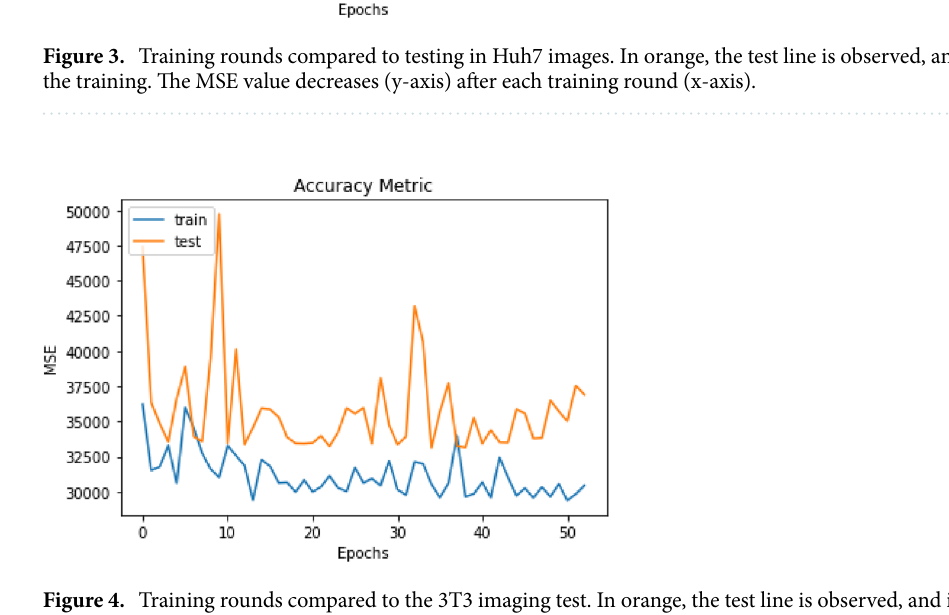
Figure 4. Training rounds compared to the 3T3 imaging test. In orange, the test line is observed, and in blue, the training. From each training round (x-axis), the MSE value dis not synchronized between test and training and remains at constant values (y-axis).